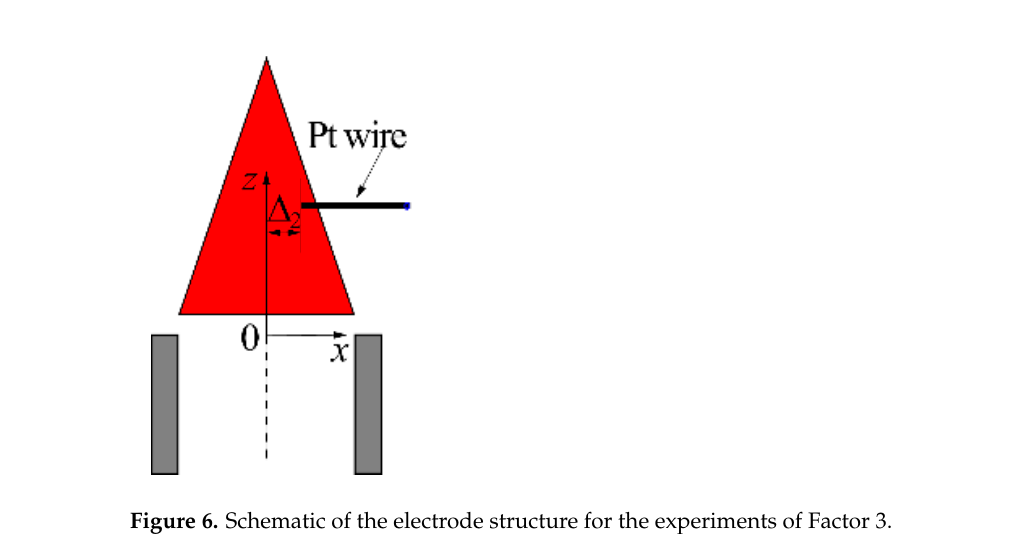
Δ = 5–65 mm: ( a ) effect of ∆ 1 = 5–65 mm: ( a ) effect of 1